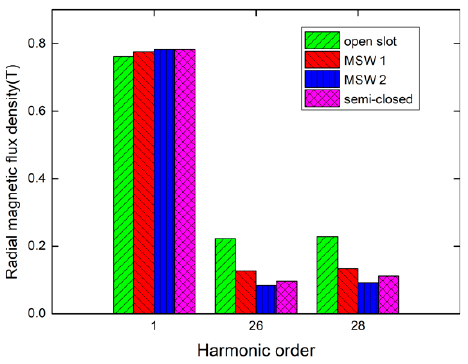
Figure 14. Radial magnetic flux density for different harmonic orders.